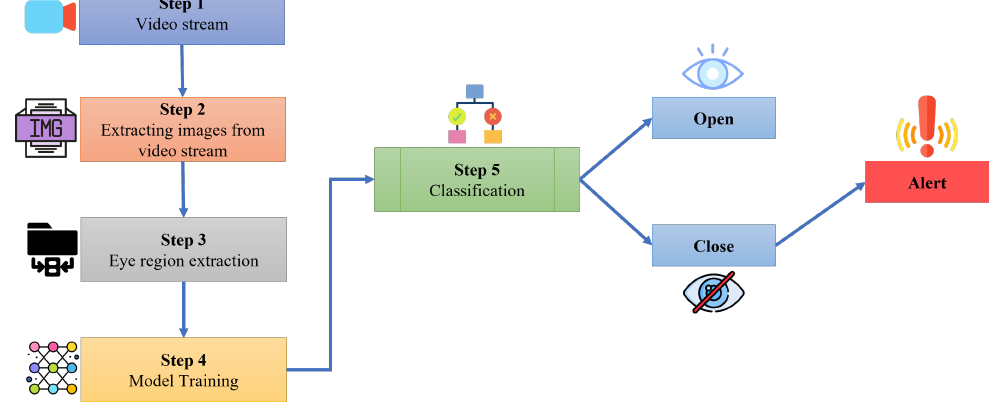
Figure 14. Flow diagram of the real-time